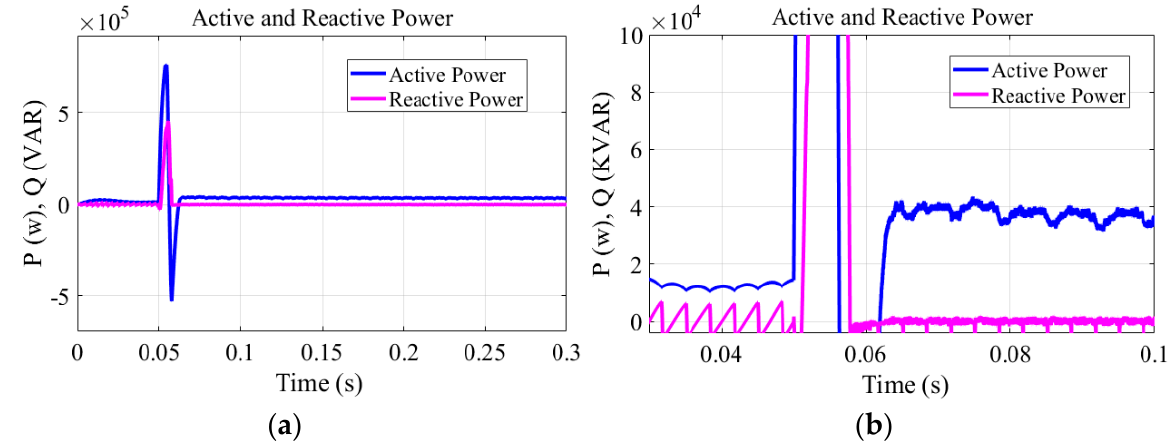
Figure 15. ( a ) Active and reactive power. ( b ) Zoom view of Figure